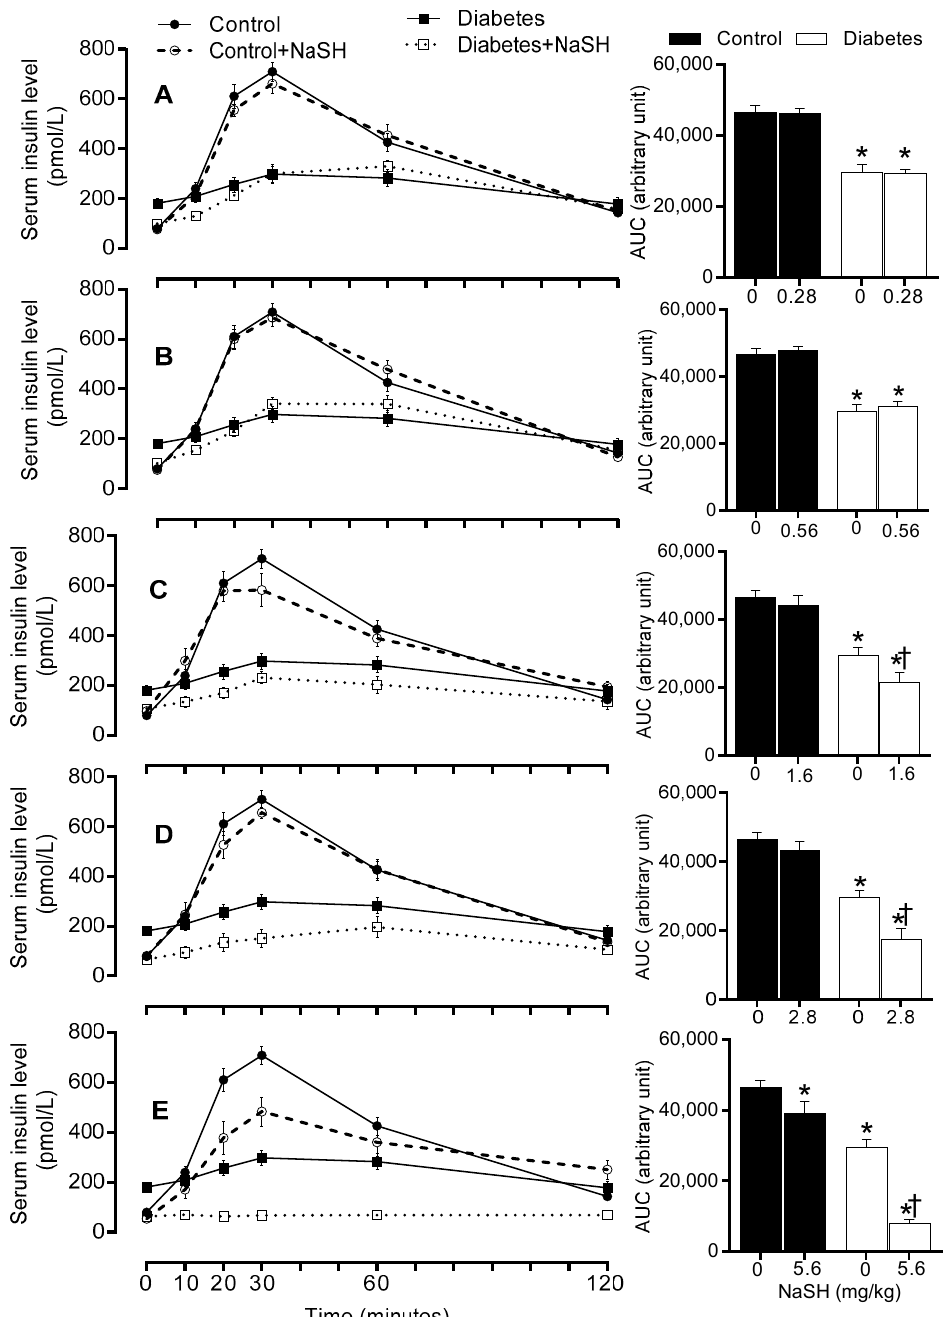
Figure 7. Effects of NaSH on in vivo insulin secretion at 0.28 ( A ), 0.56 ( B ), 1.6 ( C ), 2.8 ( D ), and 5.6 ( E ) mg/kg. Areas under the curves are shown in columns on the right. Results are mean ± SEM (n = 8/group). * p < 0.05 compared to non-treated control rats, † p < 0.05 compared to non-treated diabetic rats.